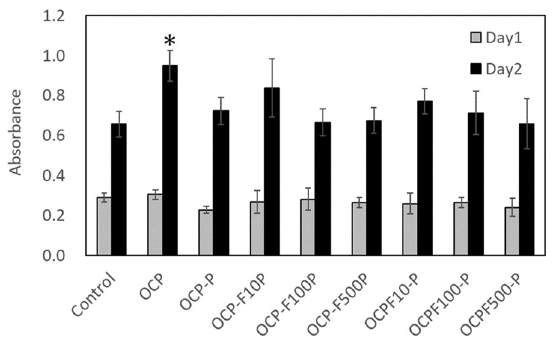
Fig. 8 Antimicrobial properties of prepared calcium phosphates for Staphylococcus aureus ( S. aureus ) ( n = 3) (* p < 0.05 compared with